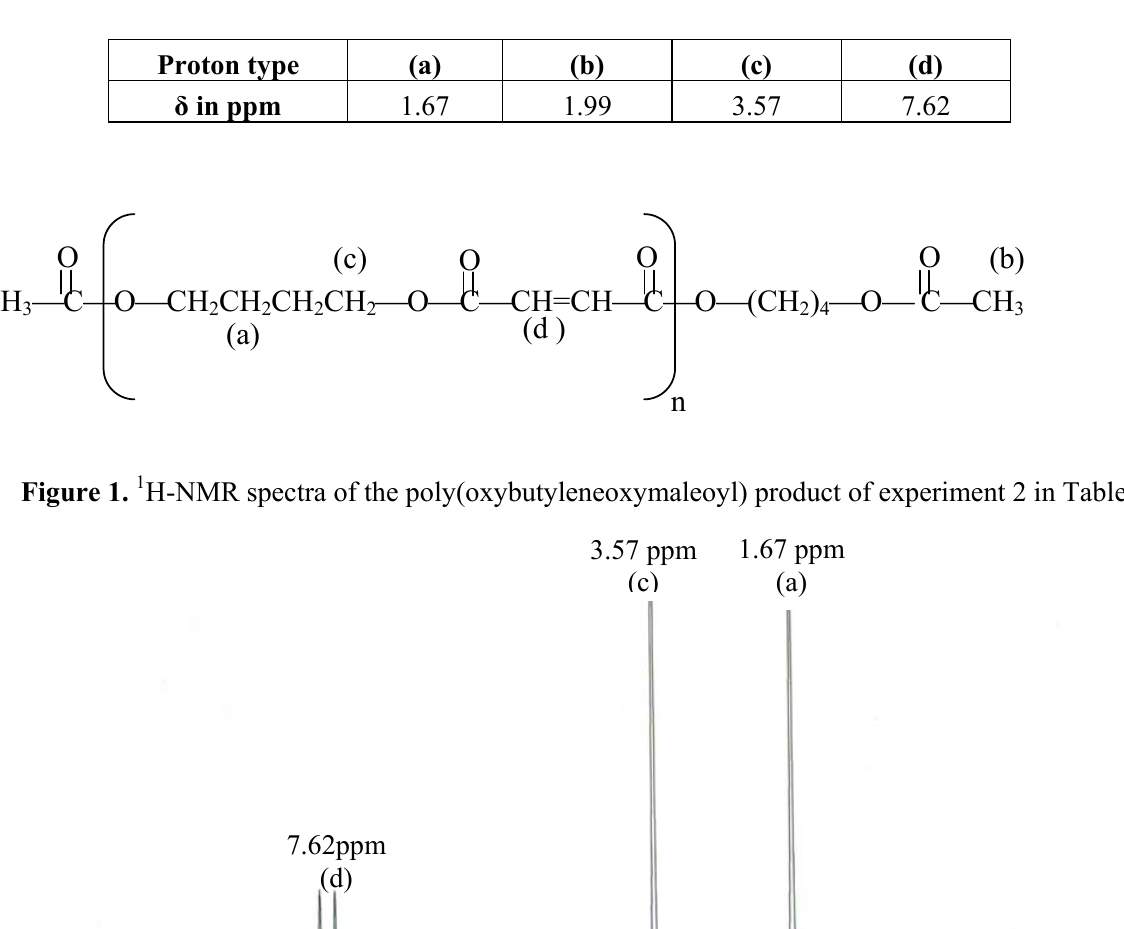
Table 5 . Product analysis by 1 H-NMR